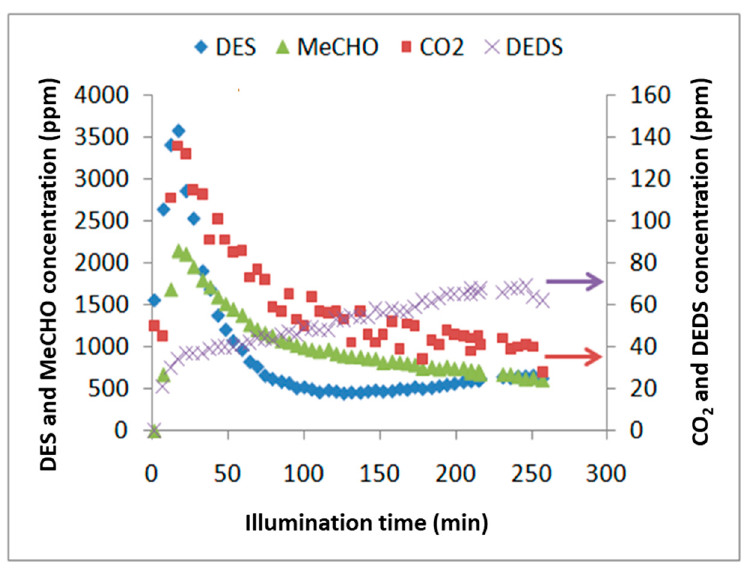
Figure 7. Evolution of the DES, CO 2 , MeCHO, and DEDS concentration as a function of the UV-A irradiation time during the degradation of DES by TiO 2 P25 immobilized onto four foams.